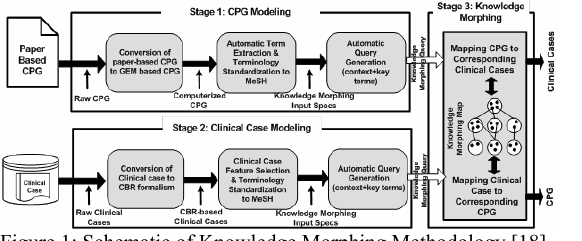
Figure 1: Schematic of Knowledge Morphing Methodology [18]